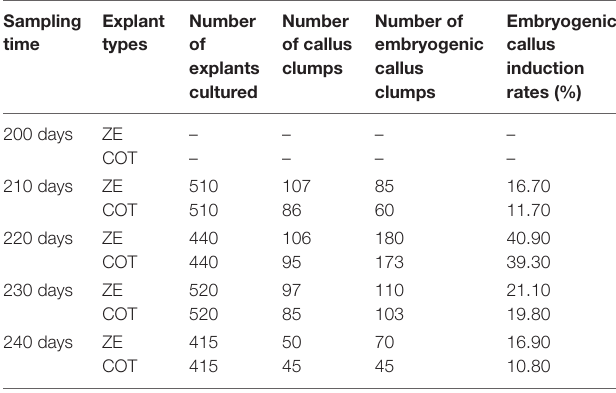
TABLE 1 | Embryogenic callus induction for C. oleifera immature seeds at different developmental stages. Sampling